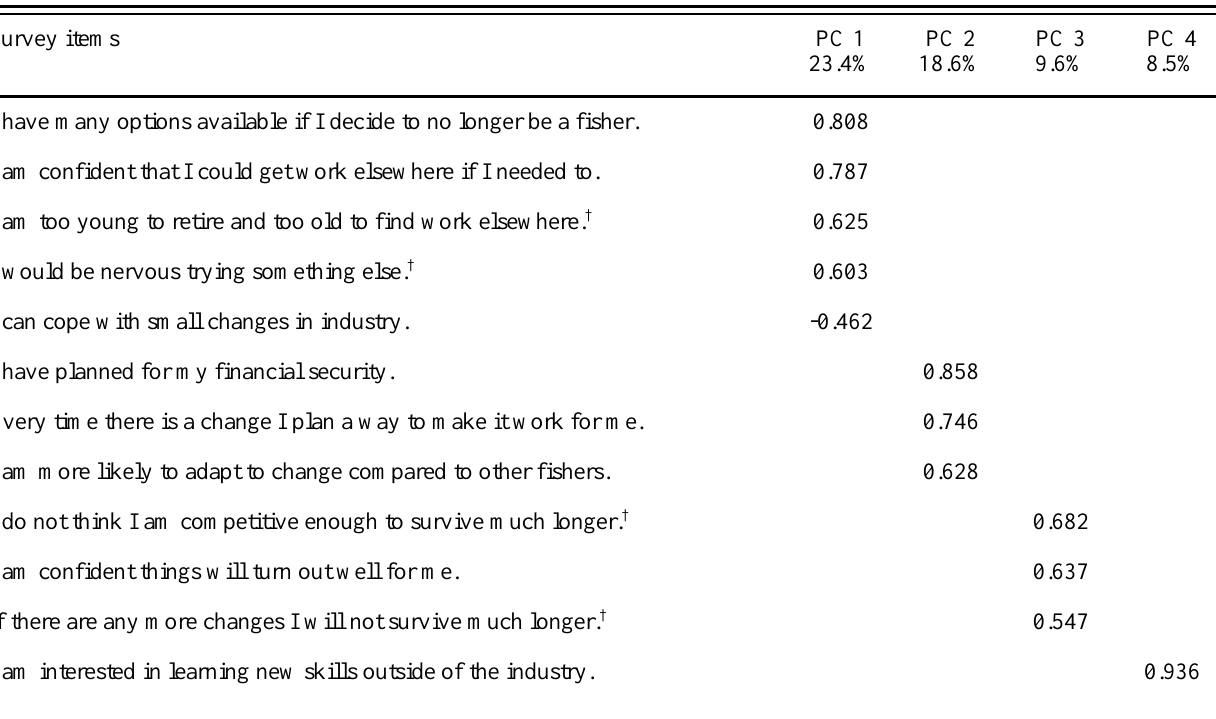
Table 2 . A Principal Components Analysis matrix of the responses of fishers to policy change. The first Principal Component (PC 1) represents statements related to the perception of risk associated with absorbing and adapting to change; these statements made reference to the ability to secure work elsewhere if the need arose, as well as the ability to cope with small changes within the industry. The second component consisted of statements related to the ability to plan, learn, and reorganize. The third component consisted of statements related to the ability to cope with change or the rate at which thresholds of coping are reached. The fourth and final component consisted of a single statement reflecting the ability and interest of fishers to adapt to change by reinventing themselves. Factor loading scores of less than 0.45 are not